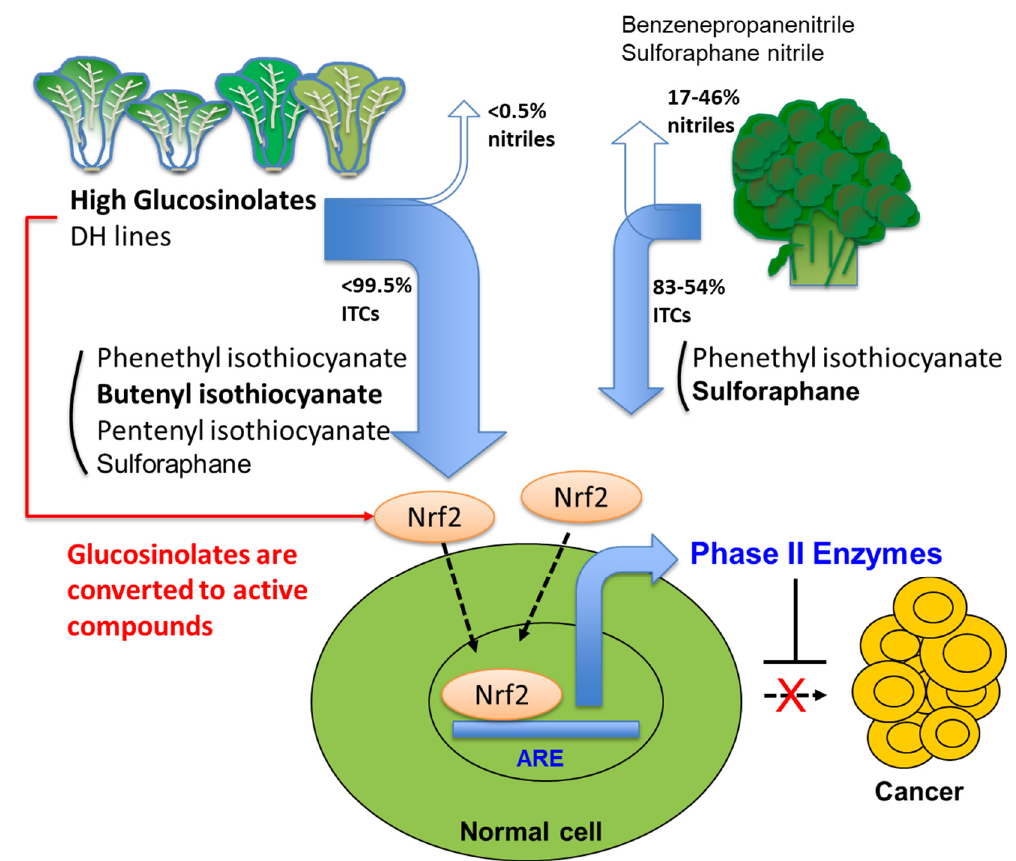
Figure 6. Comparison of cancer-preventive effect of high glucosinolate DH_line with low nitrile formation ability with broccoli as well-known cancer fighting vegetable as model. Genome-assisted precision breeding in B. rapa achieved high GSLs DH line that directly contribute to high ITCs-mediated restoration of Nrf2/ARE signaling.